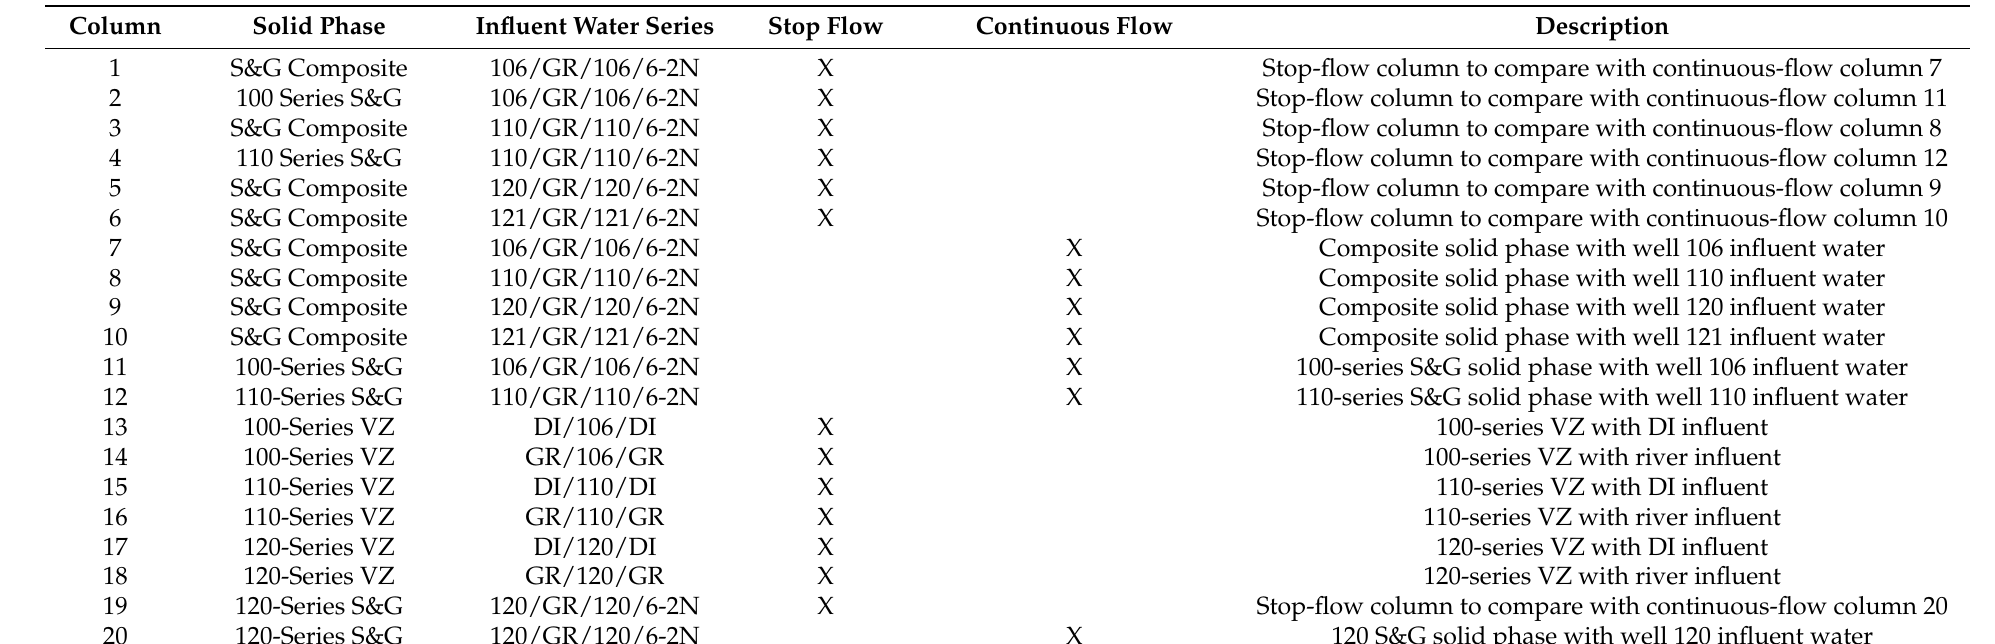
Table 1. Column-testing